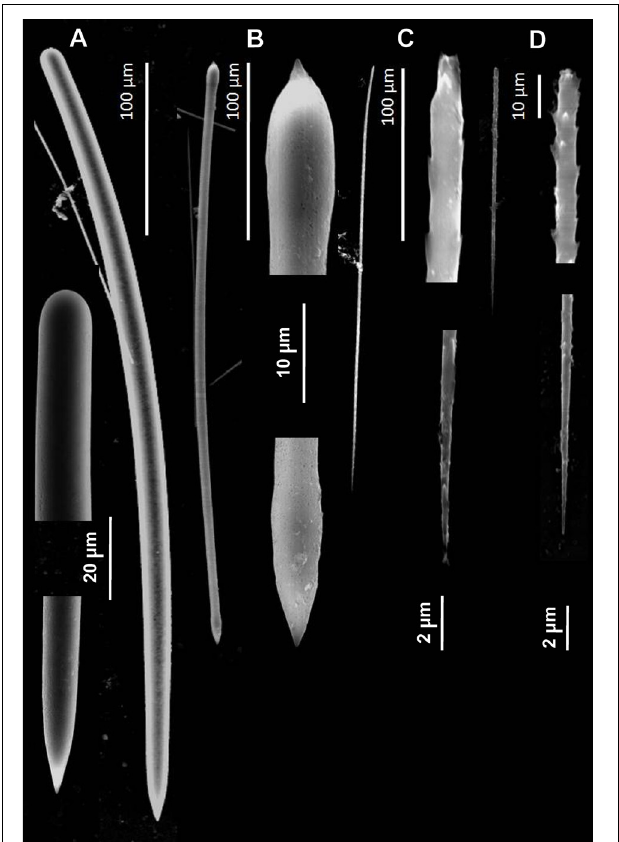
FIGURE 5 | Spicules of Tedania ( Tedaniopsis ) rappi sp. nov. (Holotype) as seen with a Scanning Electron Microscope. (A) Styles. (B) Tornotes. (C) Onychaetes I. (D) Onychaetes